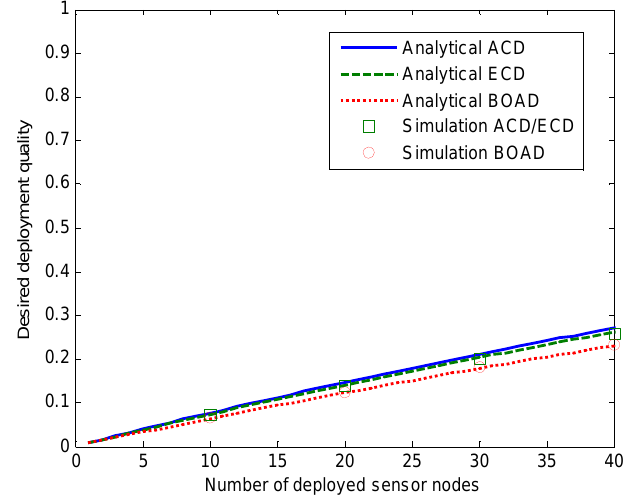
Figure 9. Effects of number of deployed sensor nodes on the DDQ for r = 5 m.